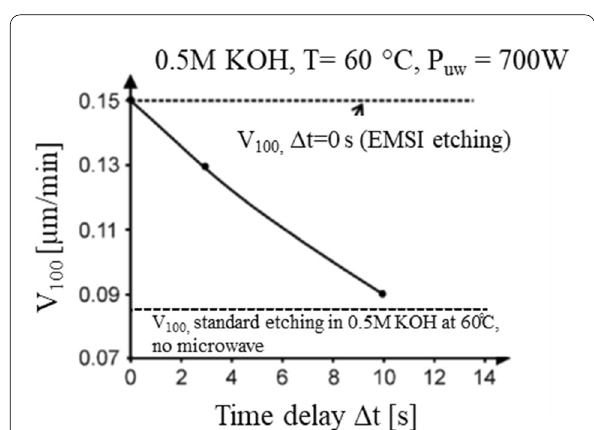
Fig. 14 Etch rate of Si{100} quickly decayed depending on time delay for introducing a microwave-irradiated solution to the etching chamber of E2MSi. Etch rates are compared between time delay of 3 s and 10 s [84], © 2004,